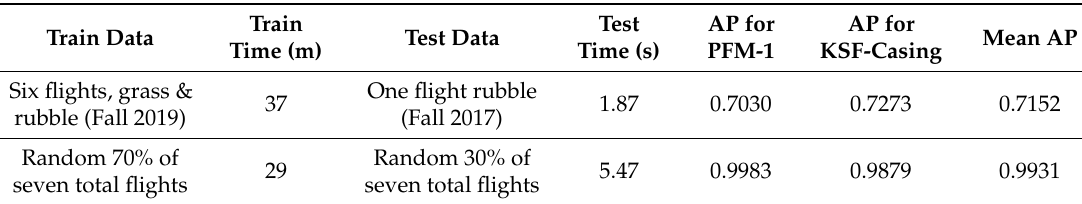
Table 2. Training and testing results for the Faster Regional-Convolutional Neural Network (Faster R-CNN).